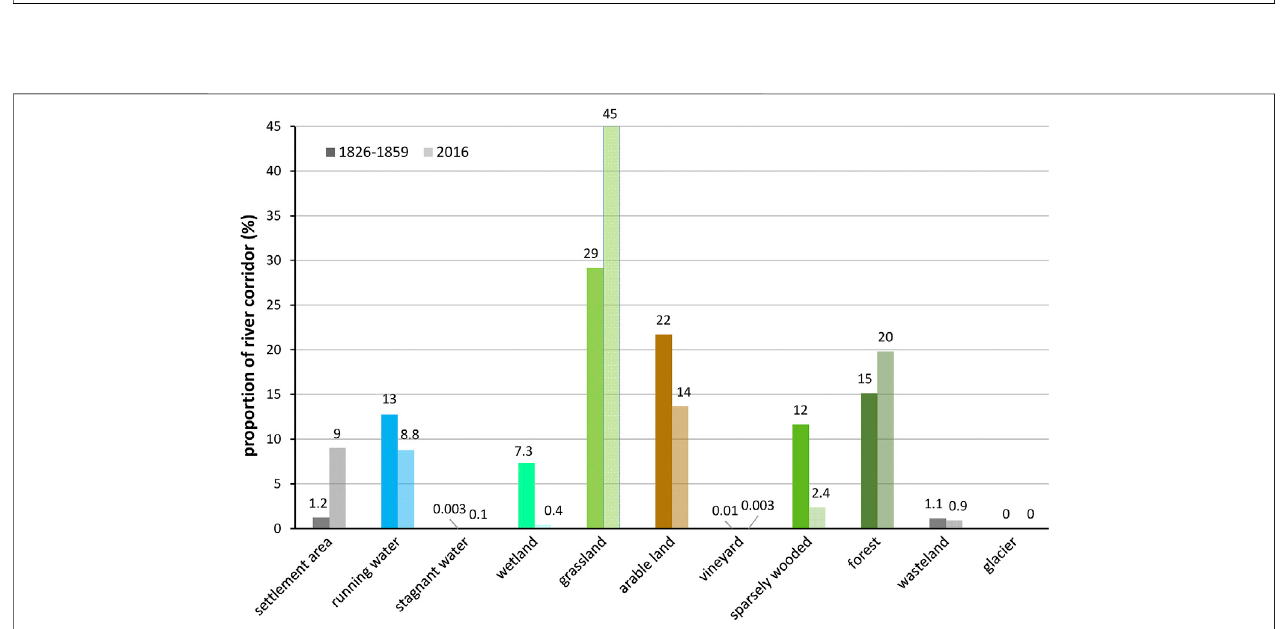
FIGURE6| Proportionsofthelandcover/usetypesinAlpine fl uvialcorridors(%)(leftcolumn:1826 – 1859,right:2016;notethatthepercentvaluesrefertodifferent large corridor areas in 1826 – 1859 and 2016).